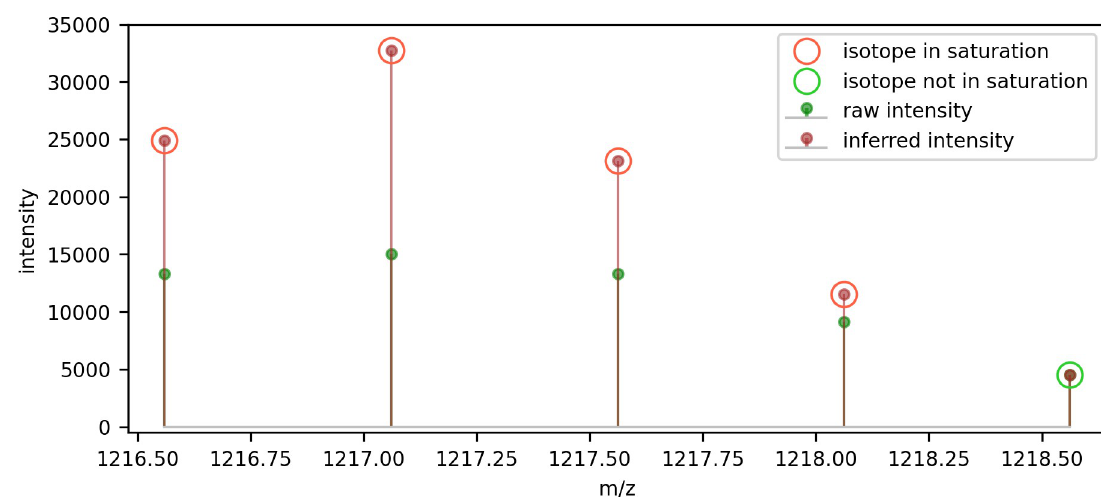
Fig 7. Using the theoretical model of tryptic peptide peak height ratios to infer isotope intensities from the first non-saturated isotope.